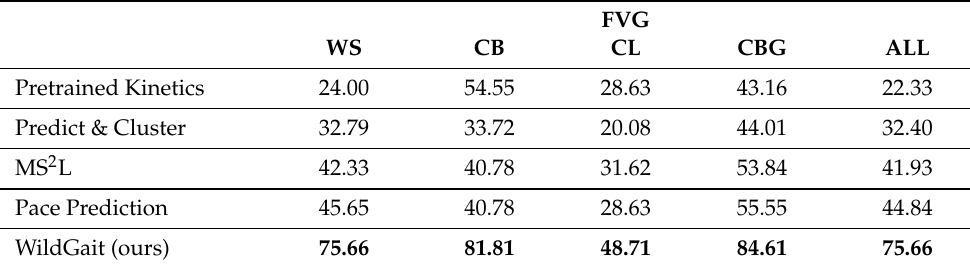
Table 4. Transfer learning comparison with other unsupervised skeleton-based training methods on FVG dataset. We highlight with bold our method (WildGait) and best results in each walking